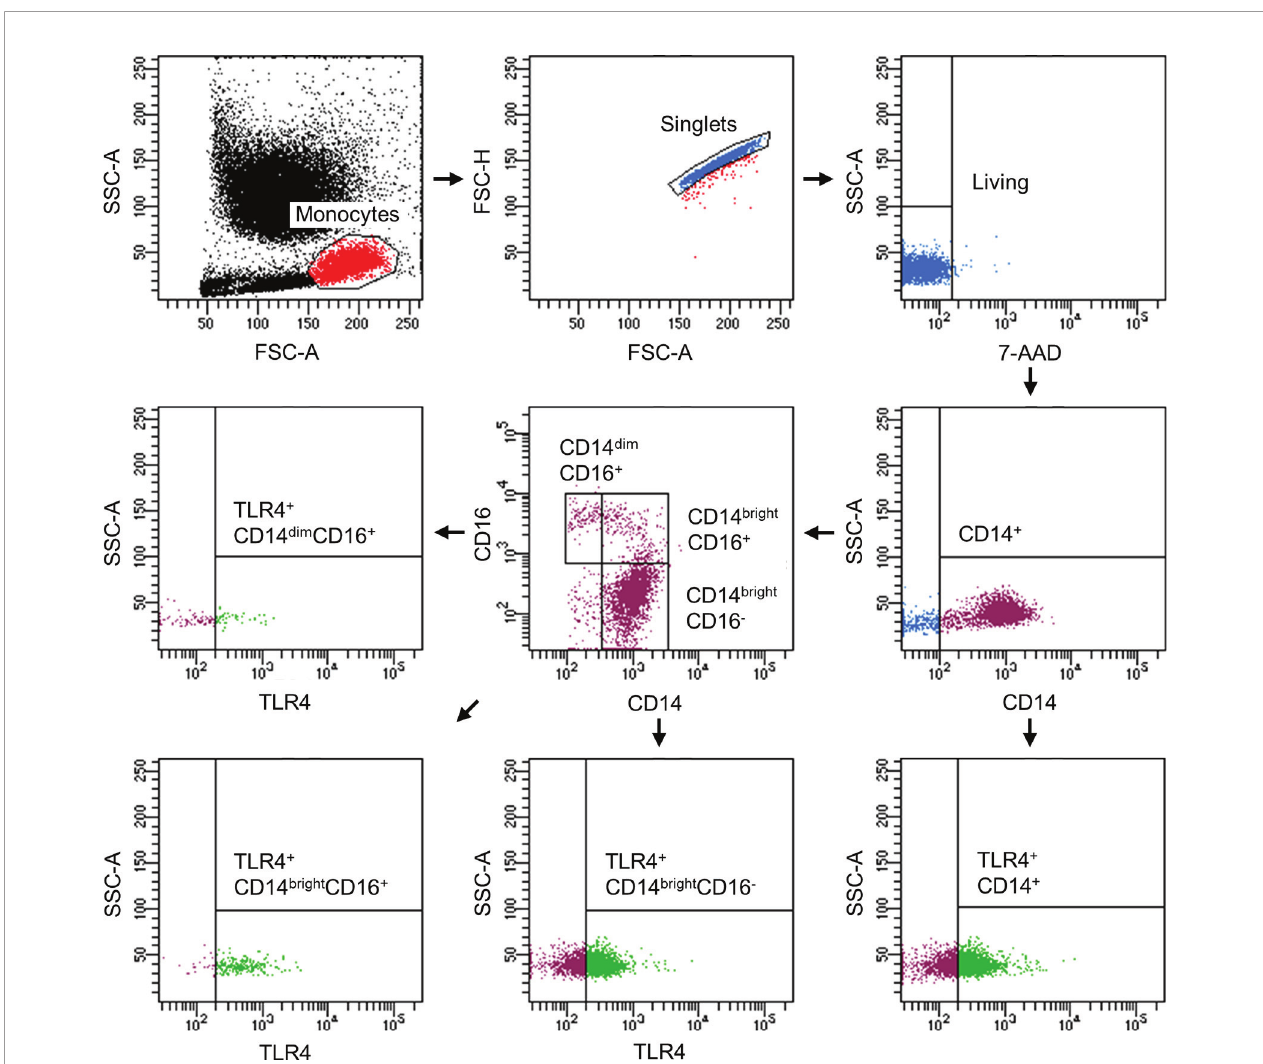
FIGURE 2 | Representative gating strategy for the fl ow cytometric analyses and evaluation of monocyte subsets with regard to their TLR4